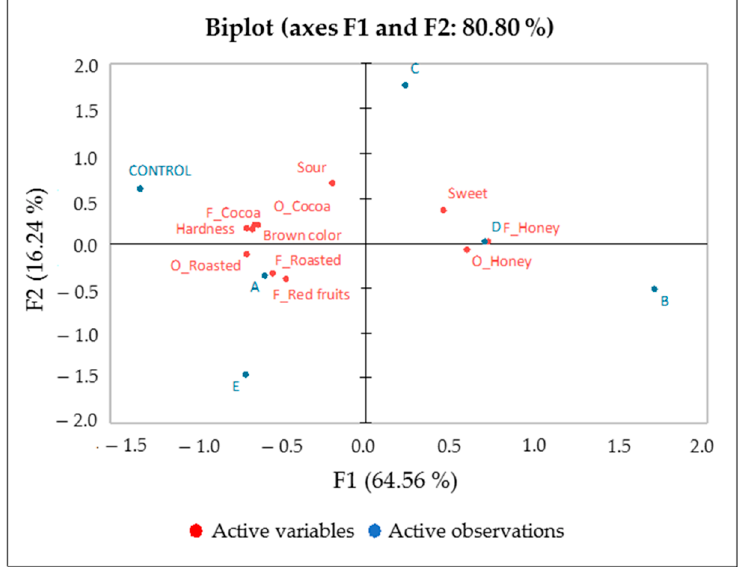
Figure 6. Biplot obtained by the PCA model of chocolate sensory data. A: inoculated with L. fabifermentans at t 0 ; B: inoculated with L. fabifermentans at t 0 and t 48 ; C: inoculated with F. rossiae at t 0 ; D: inoculated with F. rossiae at t 0 and t 48 ; E: inoculated with both strains at t 0 and t 48 . O indicates odour, F indicates